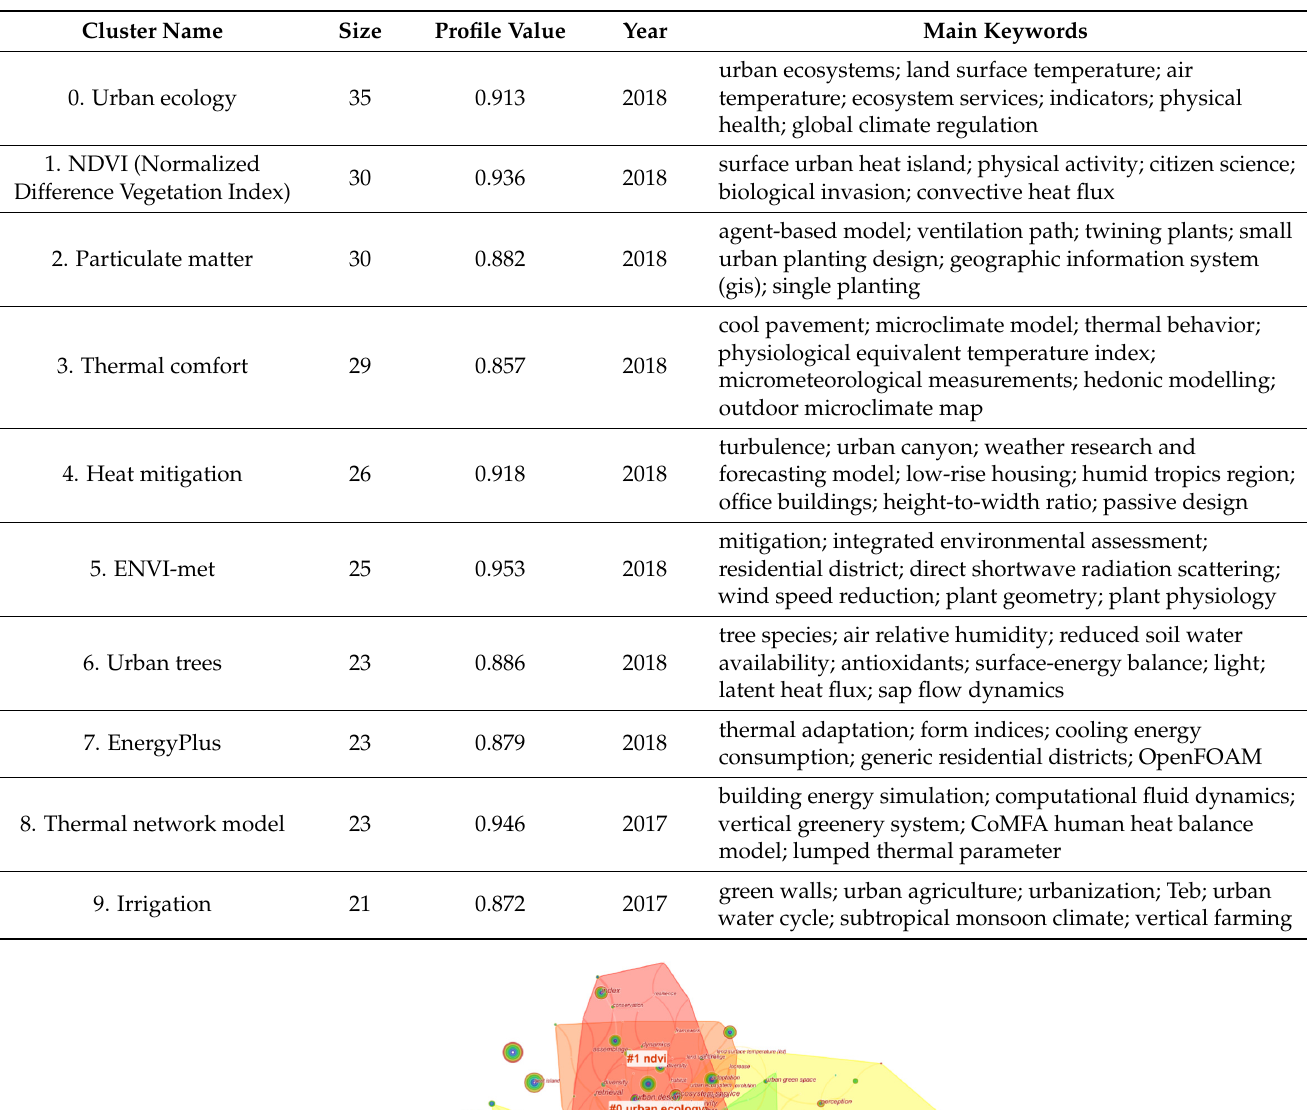
Table 4. Keyword clustering of urban microclimate research in the last five years.